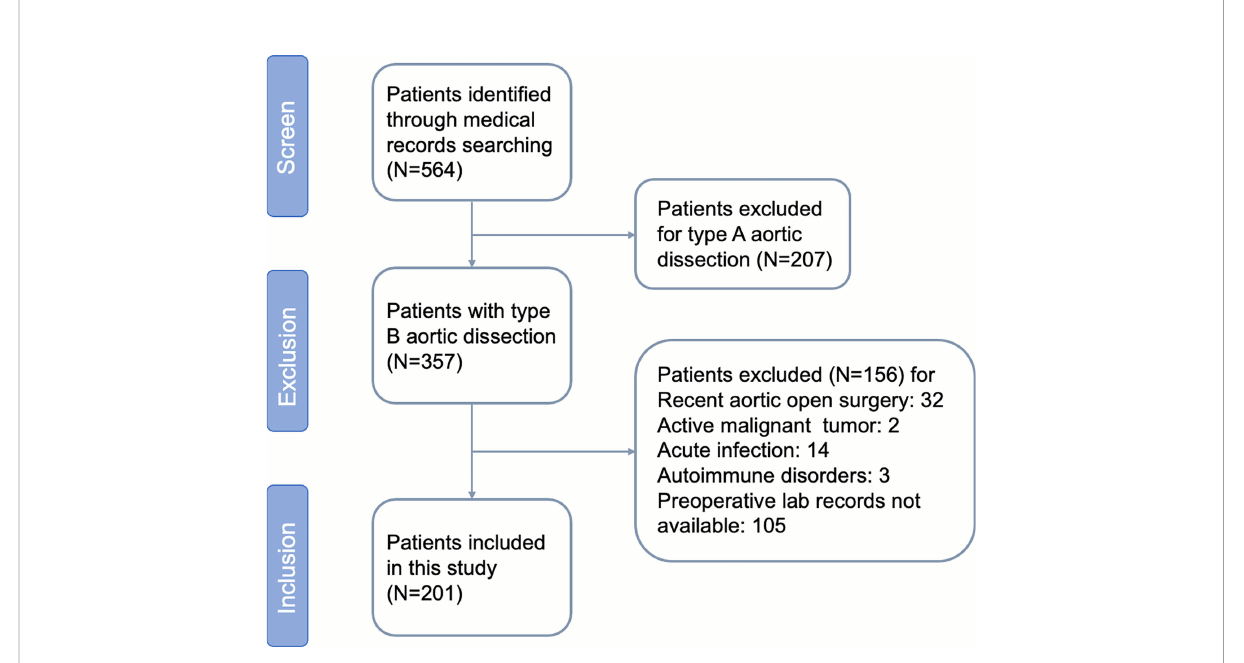
FIGURE 1 Flow diagram according to the Preferred Reporting